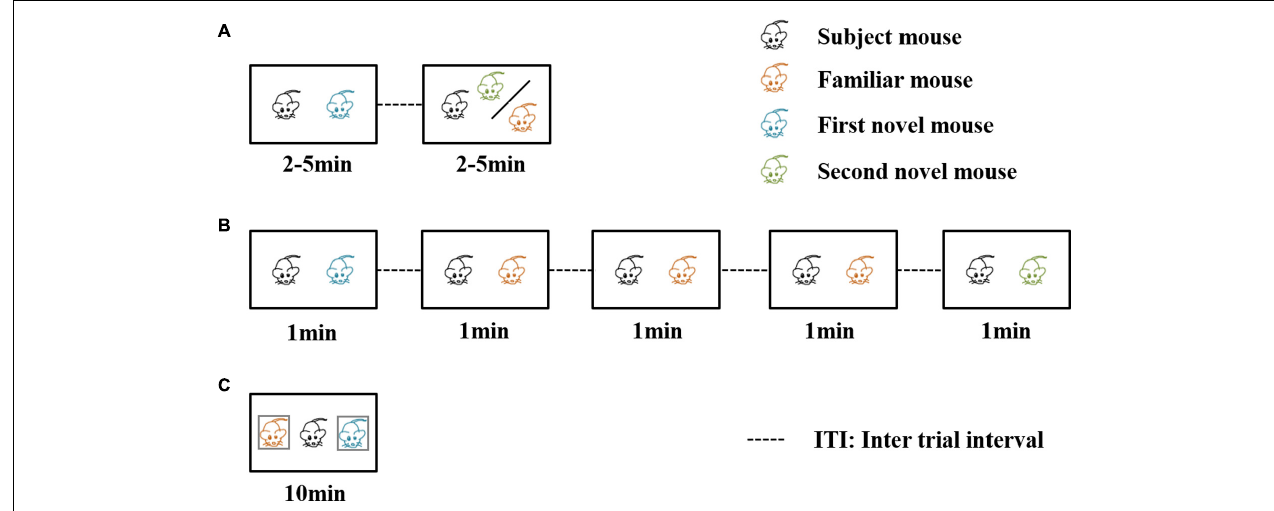
FIGURE 2 | Three behavioral paradigms for evaluating social recognition memory. In the first two of the three paradigms, a familiar mouse means the social stimulus the subject mouse has met in the previous trials. In the third paradigm, a familiar mouse refers to a cage mate of the subject mouse. (A) The direct interaction paradigm includes two encounters. The social stimulus the subject mouse meets in the second encounter can be familiar or novel. (B) The social habituation-dishabituation paradigm includes five trials of encounters. In the fifth trial, the subject mouse meets a novel social stimulus. (C) The social discrimination paradigm includes one encounter trial. The subject mouse meets two social stimuli at the same time. One is a familiar cage mate, and the other is a novel stimulus.